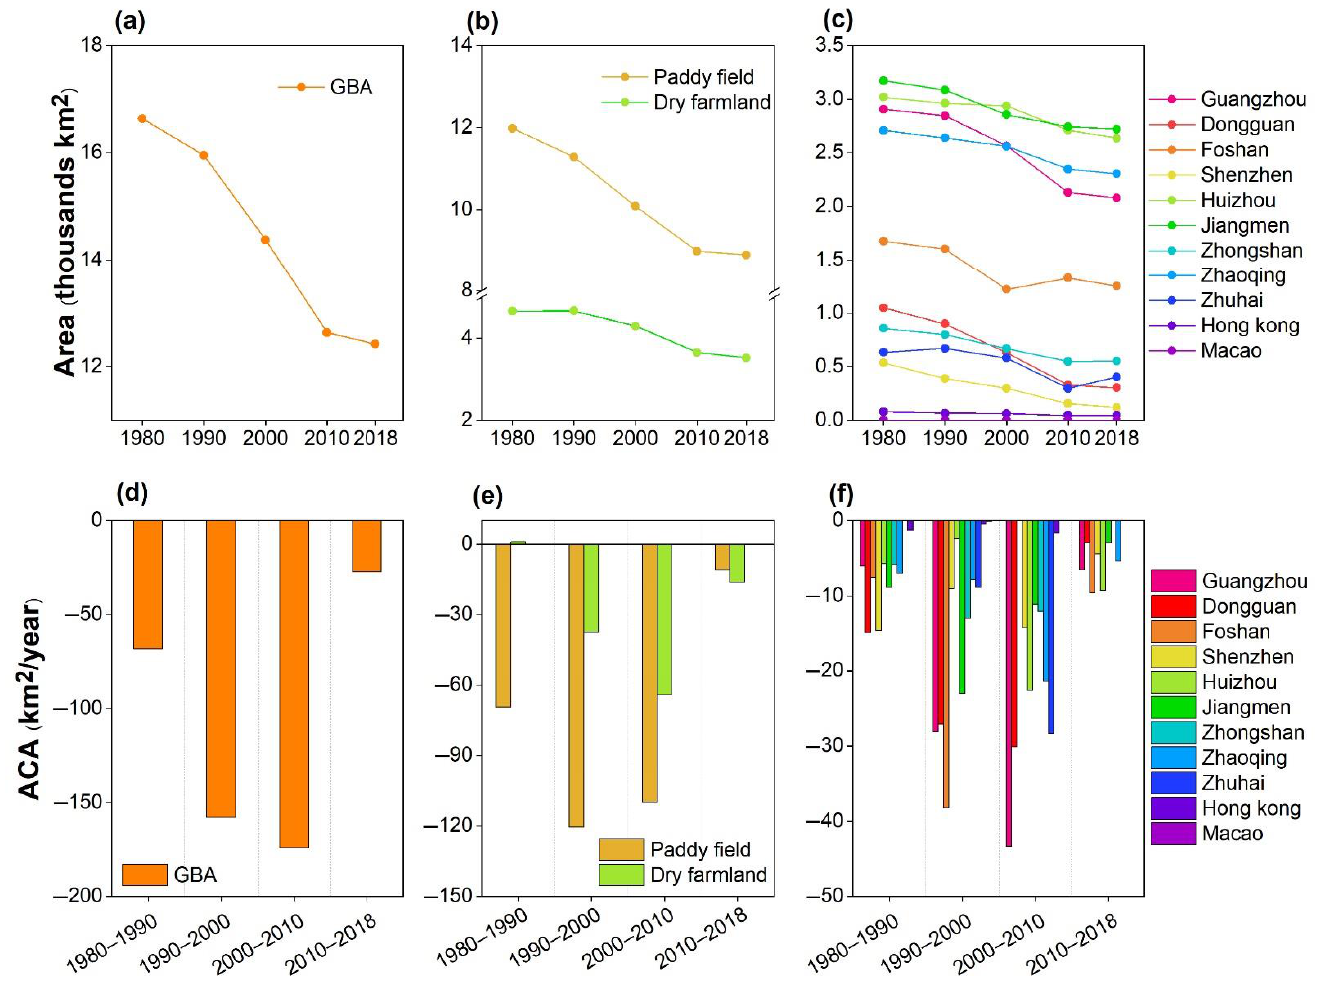
Figure 3. Farmland evolution of the GBA from 1980 to 2018: ( a – c ) are the change of farmland for the total GBA, different types and 11 cities, respectively; ( d – f) present the ACA of farmland of the total GBA, different types and 11 cities, respec- tively.